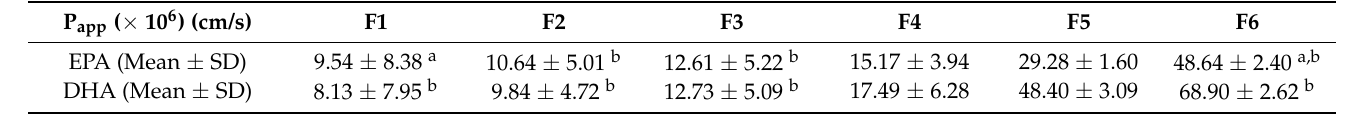
Figure 4. Apparent permeation coefficient (P app ) for ( a ) eicosapentaenoic acid (EPA) and ( b ) docosa- hexaenoic acid (DHA) of F1–F6 formulations in the in vitro permeation test. * p < 0.05 is established between SALC formulations. ** p < 0.01 is established between SALC formulations. Data are presented as mean ± SD ( n = 3). Table 3. Apparent permeation coefficient of F1–F6 formulations in vitro permeation